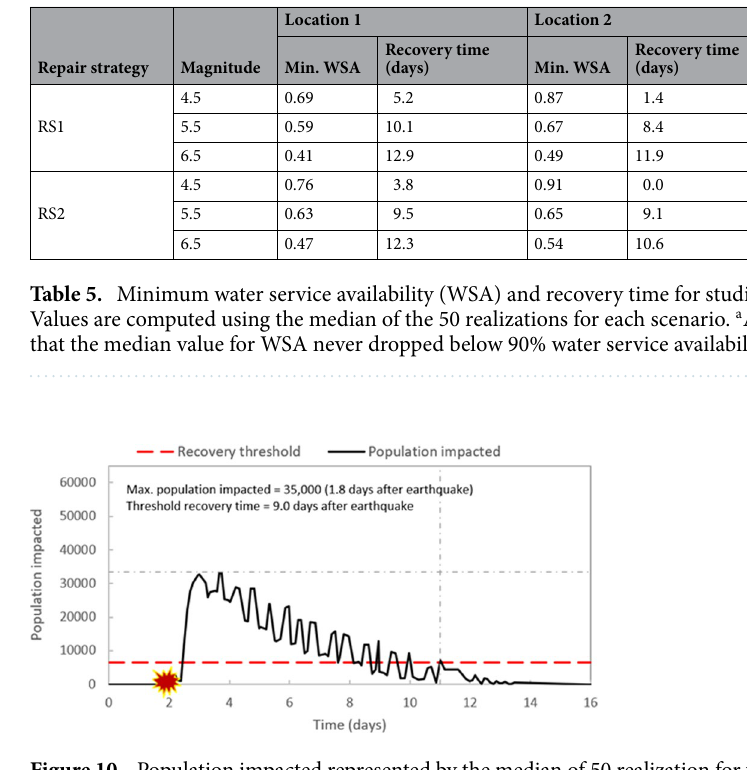
Figure 10. Population impacted represented by the median of 50 realization for the scenario of 5.5 M earthquake at Location 1 with repair strategy